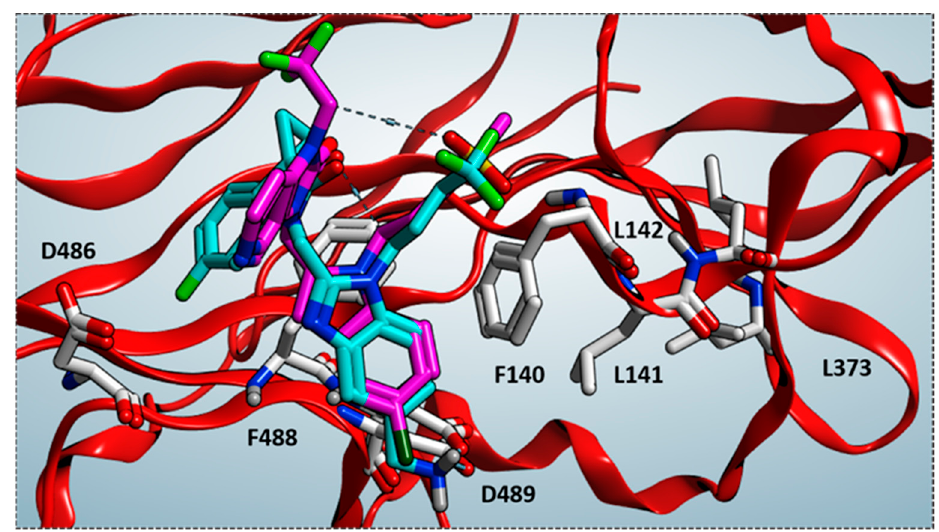
Figure 4. Superimposition of the X-ray complexes of the RSV F protein in presence of the two inhibitors RV521 (C atom in cyan; pdb code = 7KQD) [28] and JNJ-53718678 (C atom in magenta; pdb code = 5KWW) [27].